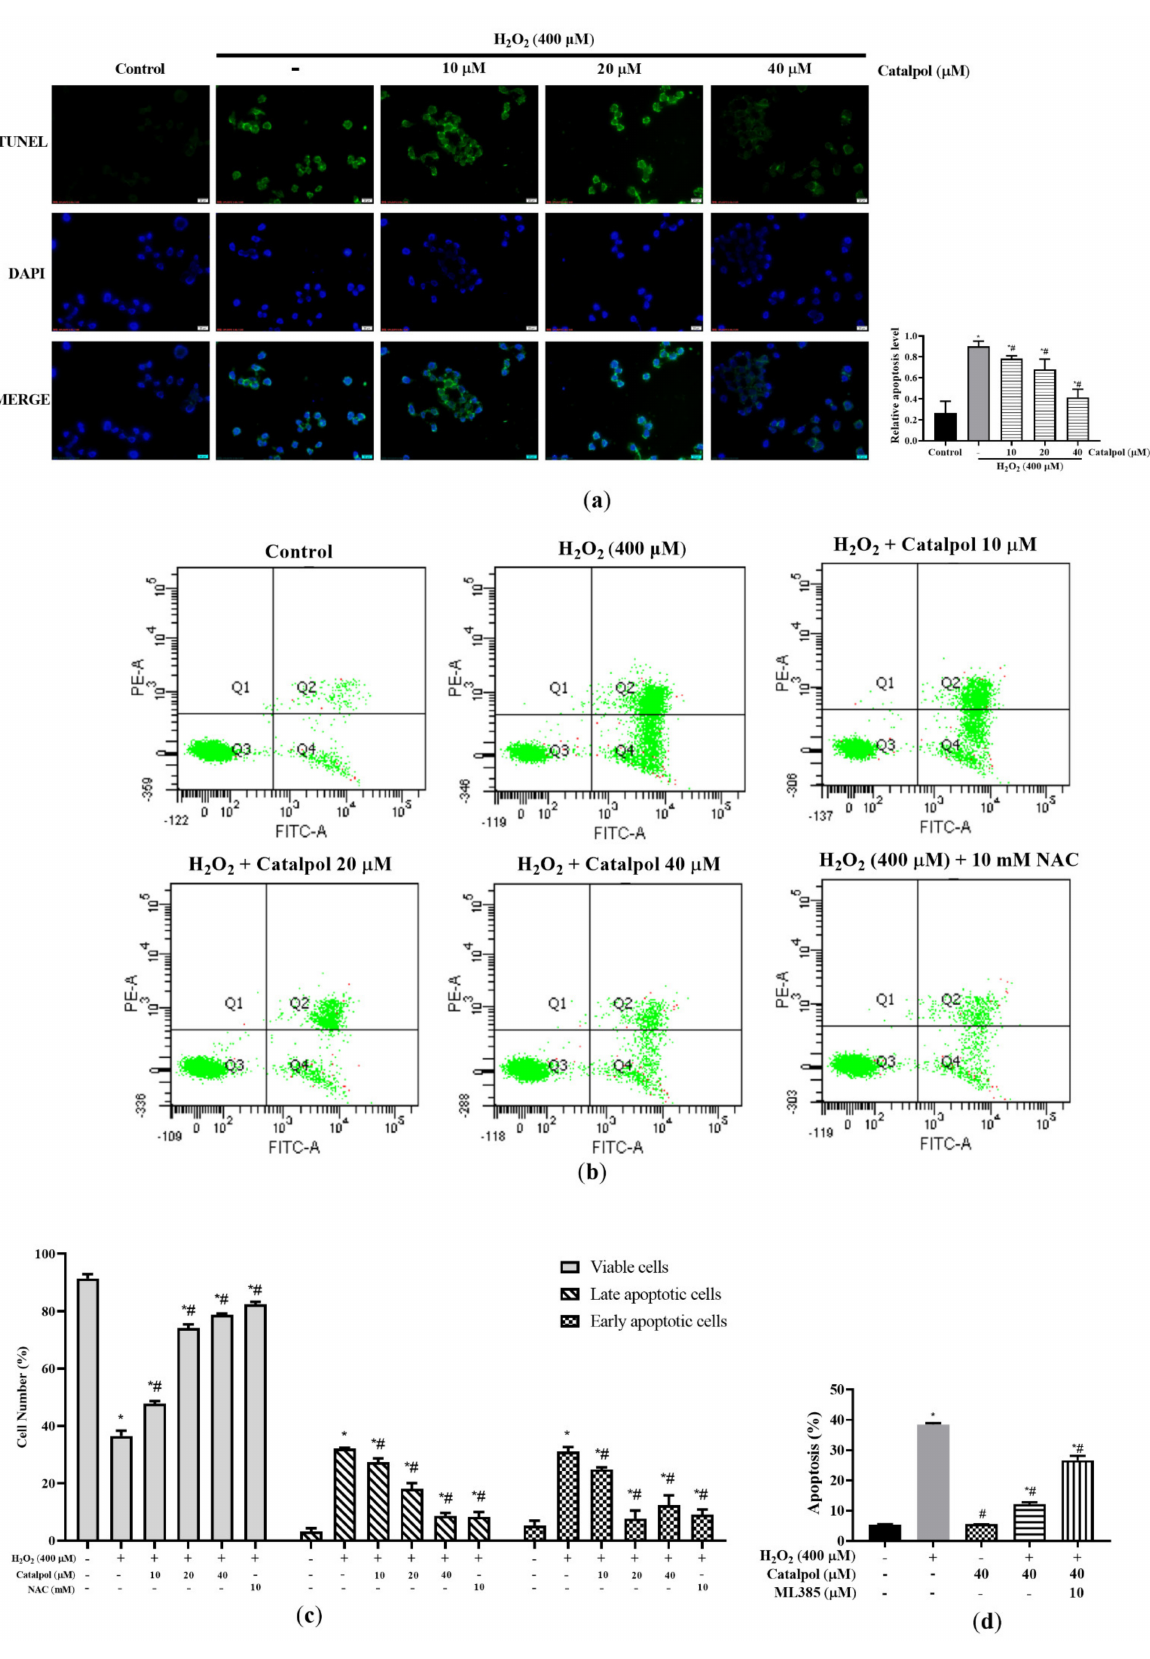
Figure 2. Catalpol exerted anti-apoptotic protective effect on H 2 O 2 -induced RPE cells. ( a ) ARPE-19 cells were treated with H 2 O 2 (400 µ M) in the presence or absence of catalpol (10, 20 and 40 µ M) for 6 h. TUNEL assay was preformed according